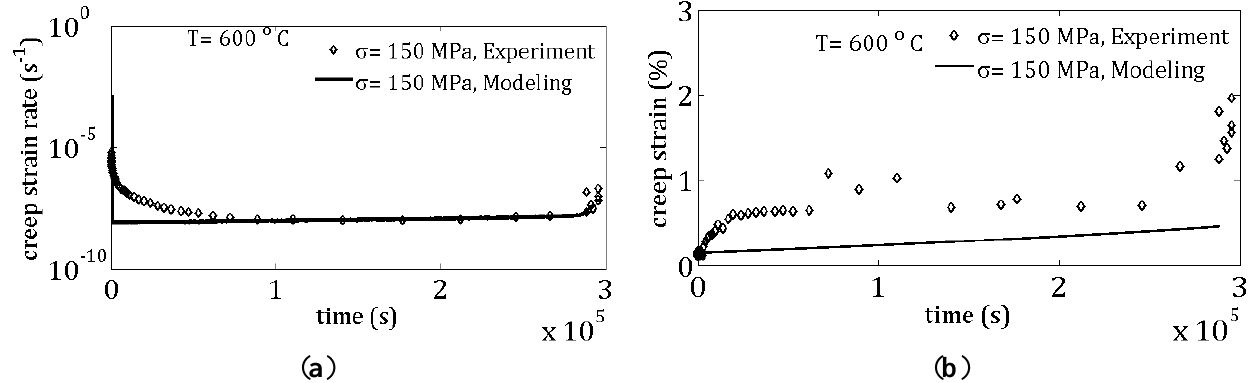
Figure 8. Creep results from experiments and finite element simulation for 150 MPa and 600 °C: ( a ) creep strain rate versus time; and ( b ) true creep strain versus